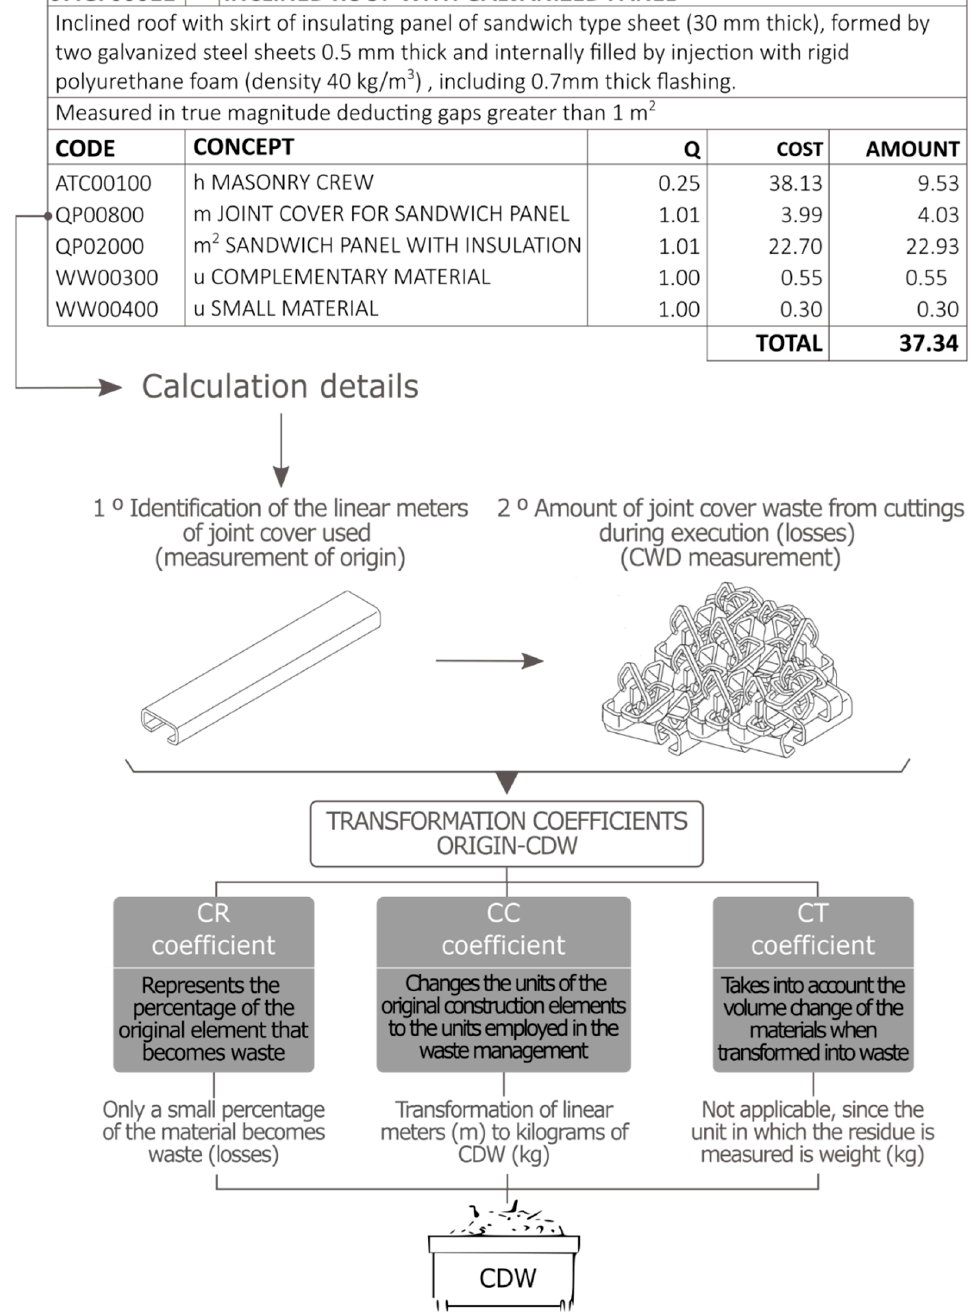
Figure 4. Example of unit cost of chapter roof and the calculation of CDW using the transformation coefficients.